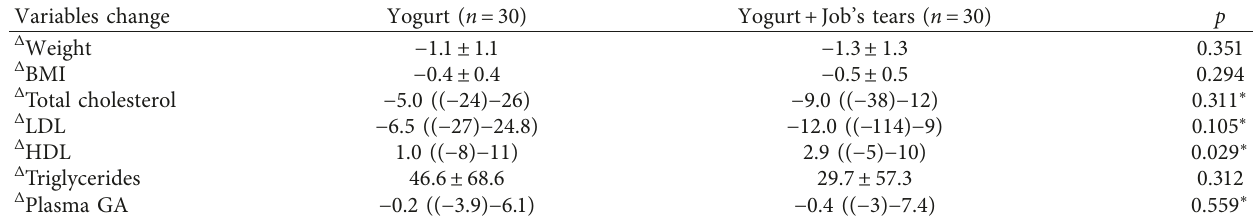
Table 3: The effects of intervention between the groups.